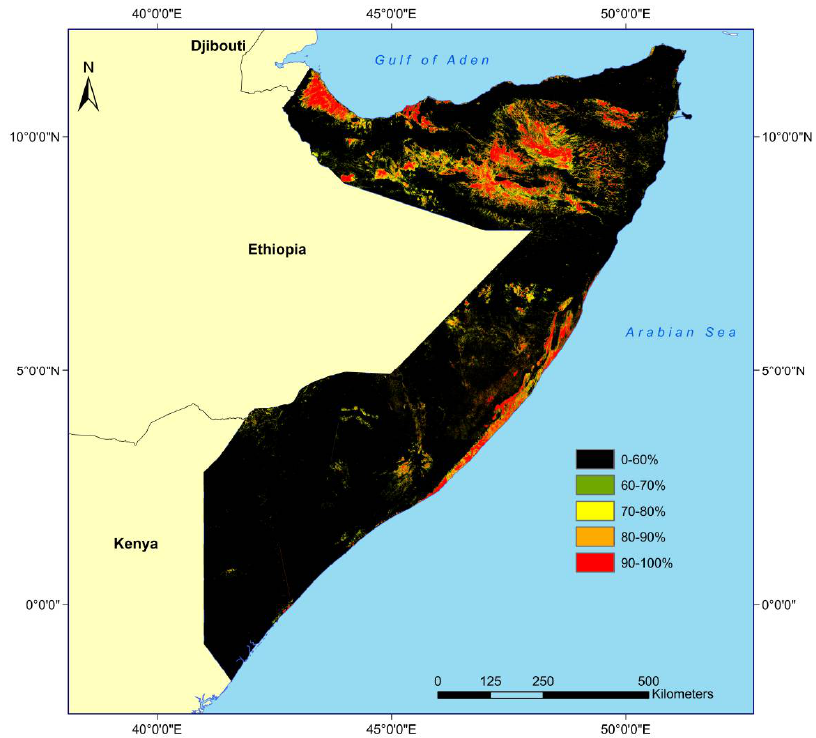
Figure 12. Relative frequency classes related to SEL 60–100% based on a three-year Sentinel-1 time-series computed for Somalia based on 1553 VV polarized Sentinel-1 data sets. computed for Somalia based on 1553 VV polarized Sentinel-1 data